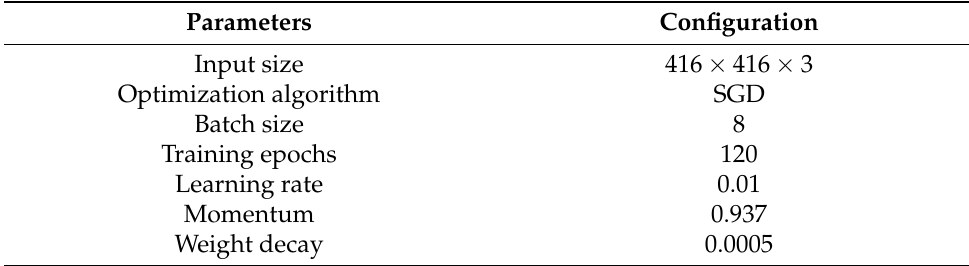
Table 4. Experimental